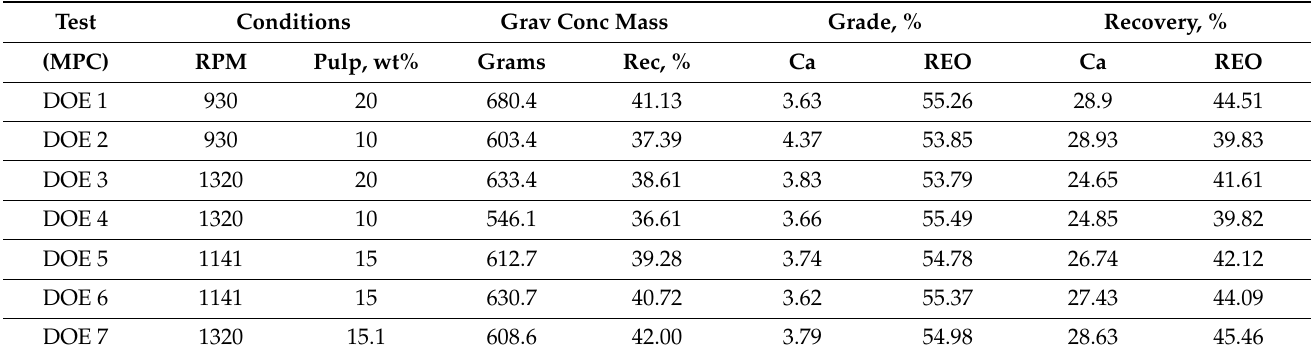
Figure 7. Mineral liberation by grouped REE minerals in MPC material MLA sample. Table 3. UF Falcon DOE Matrix conditions and